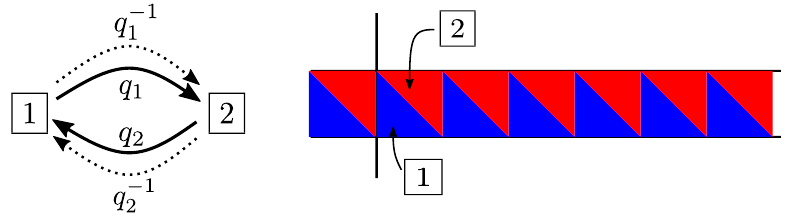
Figure 17. Subquiver and shape of one-dimensional crystal associated with external leg ‘ 2 . The external leg is surrounded by two divisors p m 2 ∪ m 4 = { α 2 , β 2 } . We note α 2 = q − 1